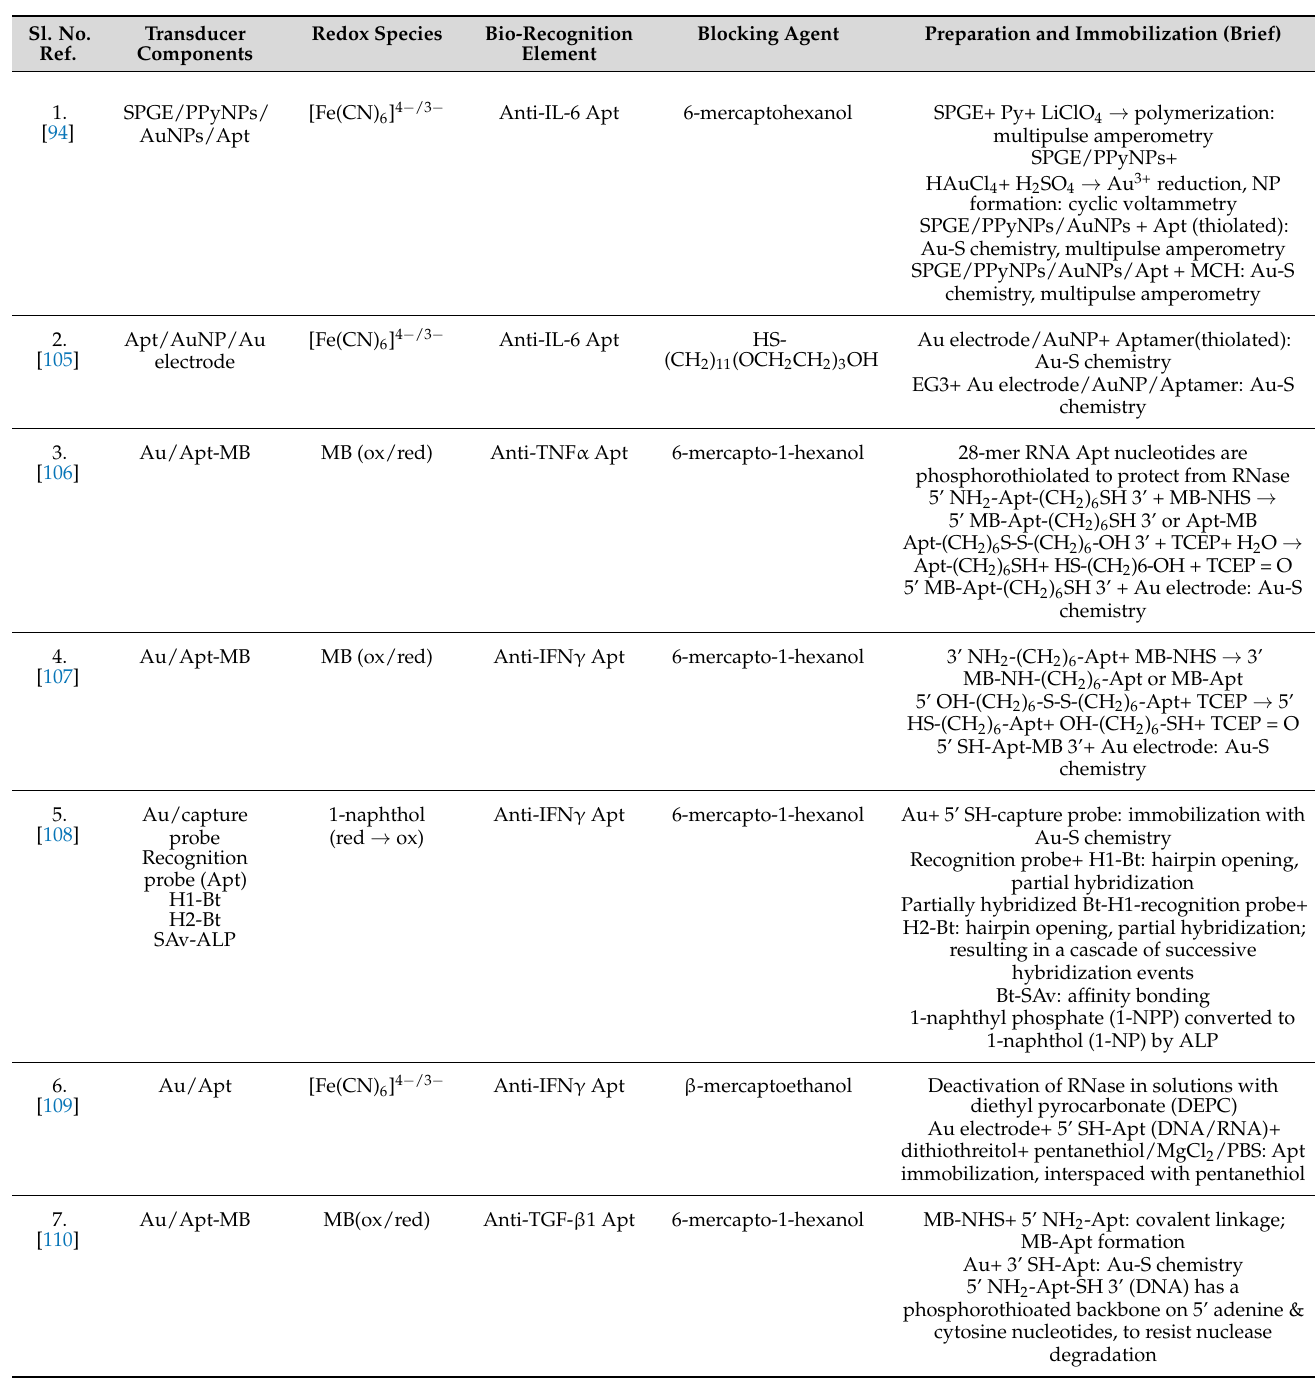
Table 1. Aptasensors: Design and sensor